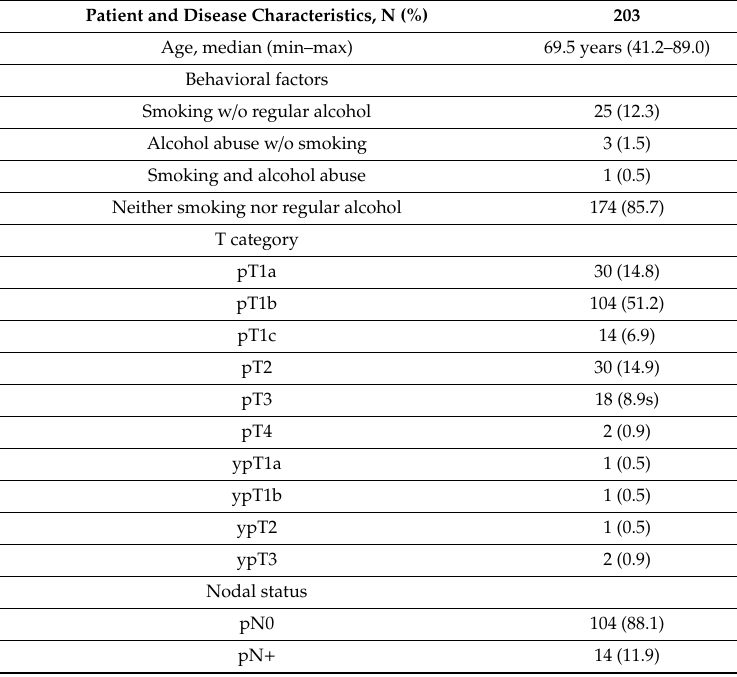
Table 1. Baseline patient and disease